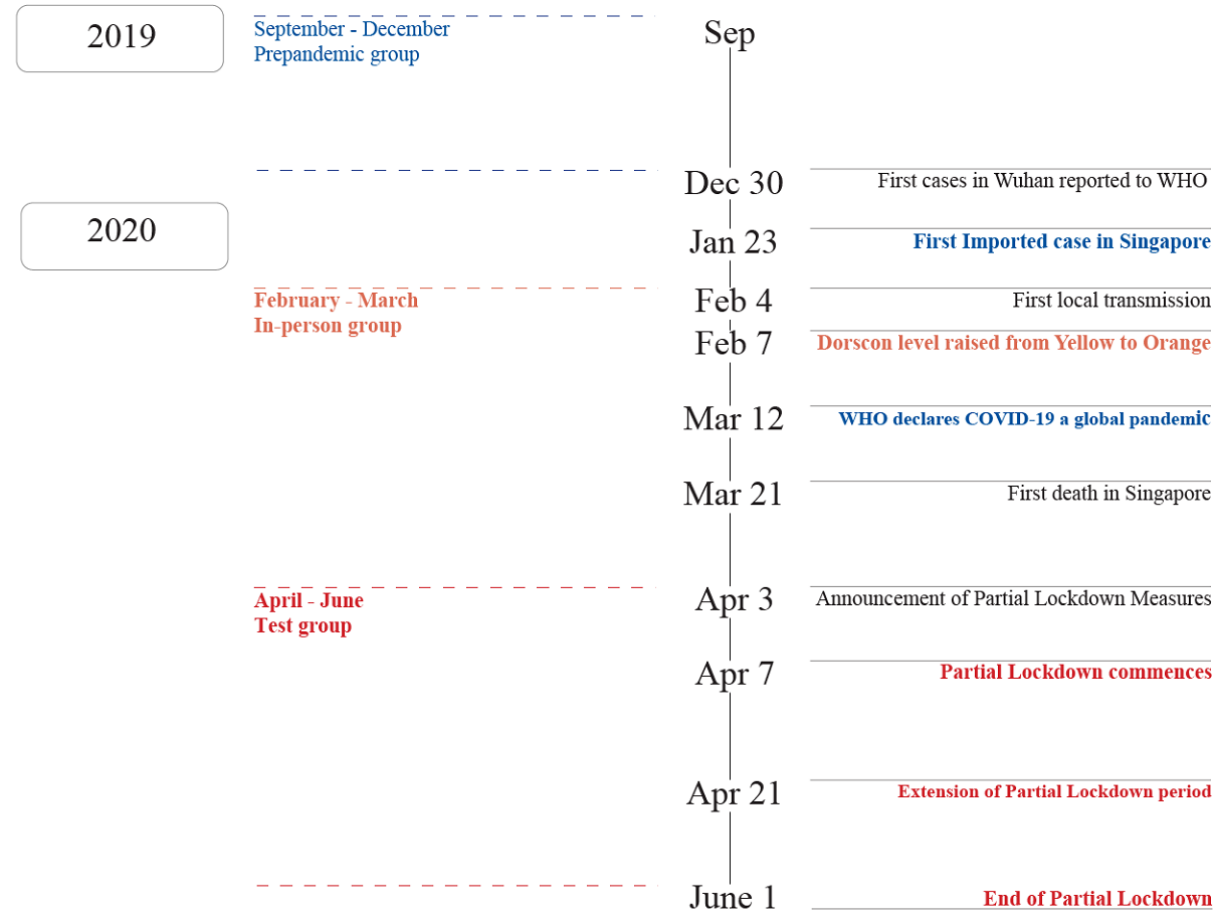
Figure 1. Timeline of key COVID events in Singapore and recruitment